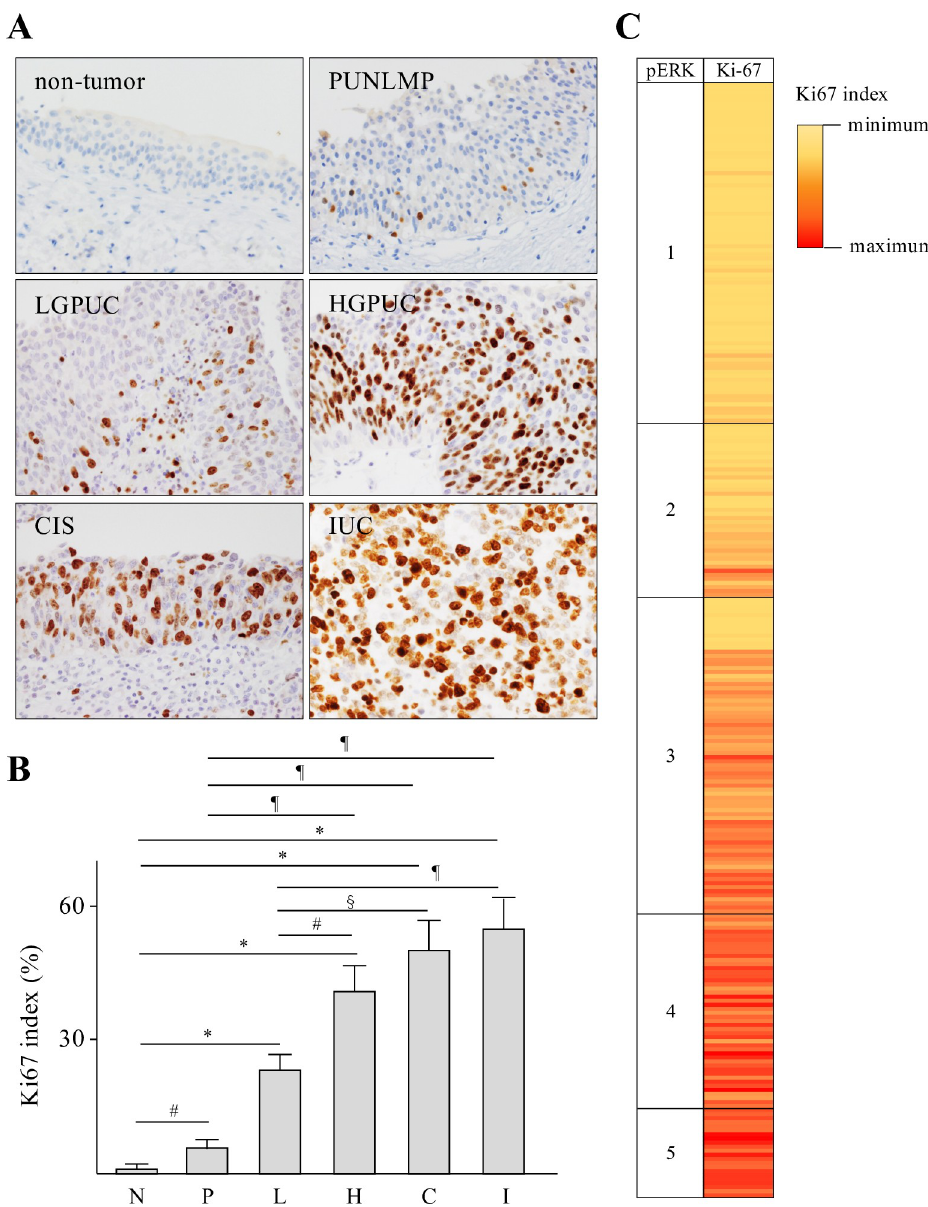
Fig 4. Ki67 index in urothelial tumors. (A) Representative photographs of Ki67 immunohistochemistry (original magnification 400 × ) from each category are shown. (B) Ki67 index in each category was shown (N: non-tumor; n = 101, P: PUNLMP; n = 19, L: LGPUC; n = 41, H: HGPUC; n = 43, C: CIS; n = 39, and I: IUC; n = 32). Data were mean ± SEM. # p < 0.05, § p < 0.01, ¶ p < 0.001, � p < 0.0001 (Dunn’s multiple comparison